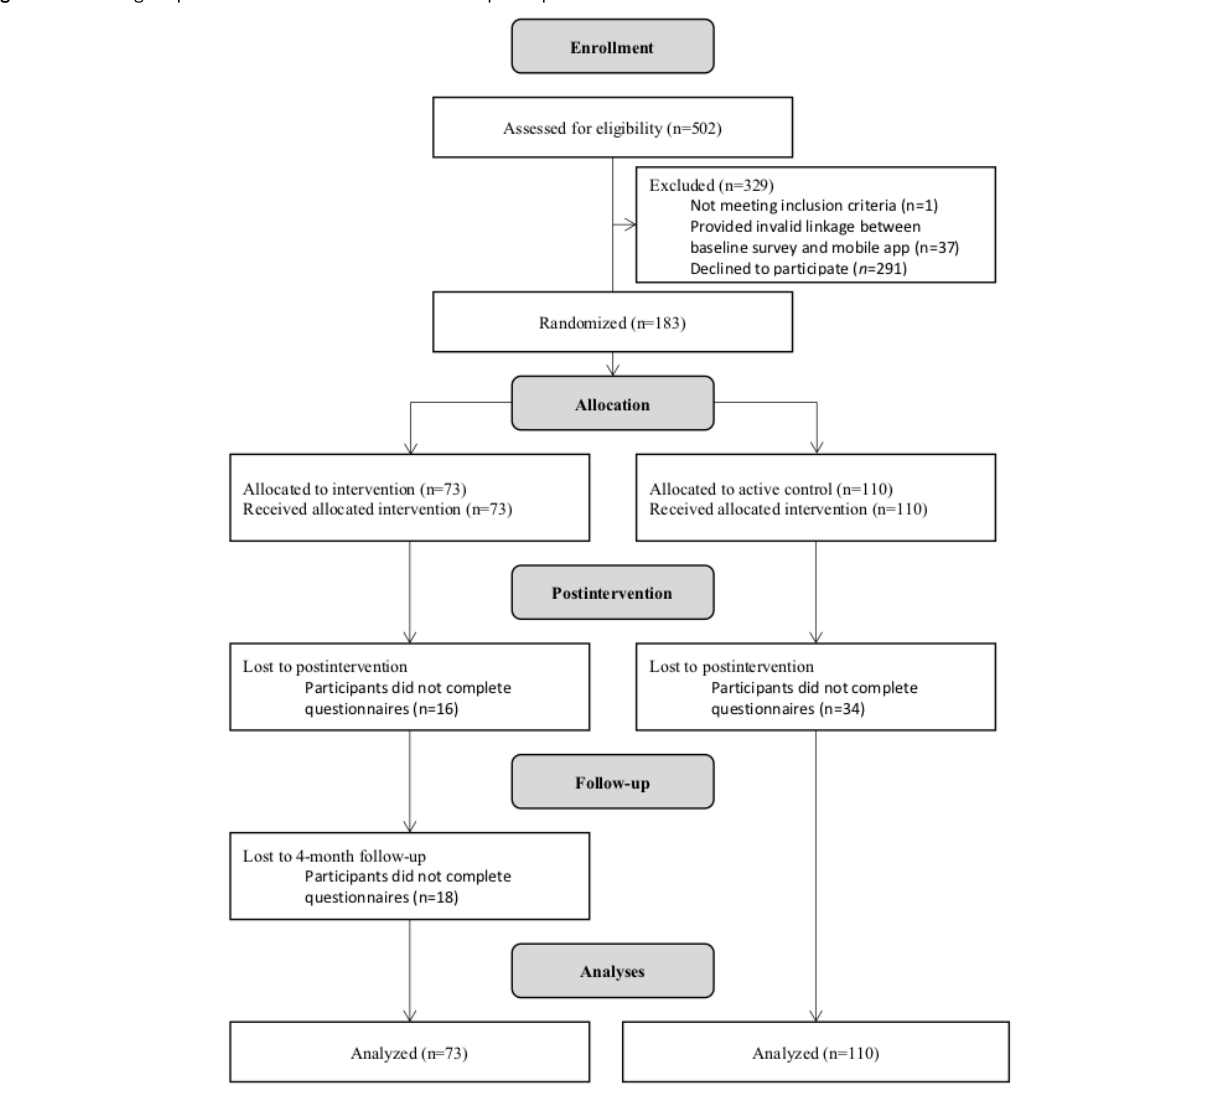
Figure 1. This Figure provides a CONSORT flow chart of participant